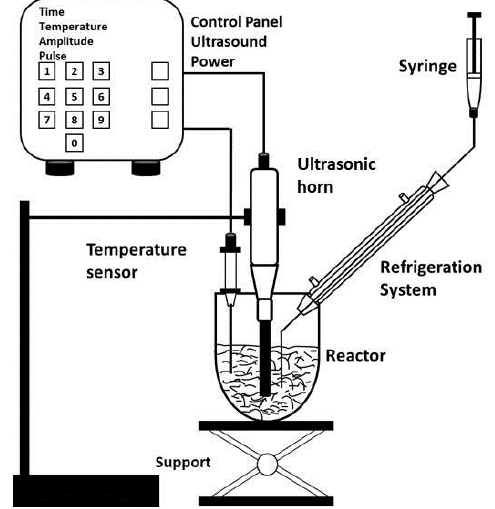
Figure 2. Schematic representation of the experimental setup. Table 2. Experimental conditions. Properties of biodiesel produced from rapeseed oil and comparison with the EN 14214